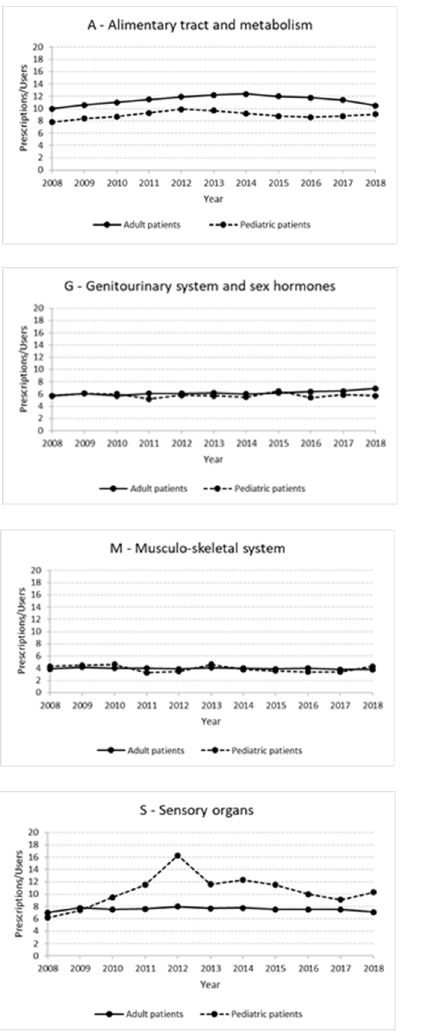
Figure 3. Graphs showing the prevalence of use for each therapeutic category in adult and pediatric RD patients in the period 2008–2018.